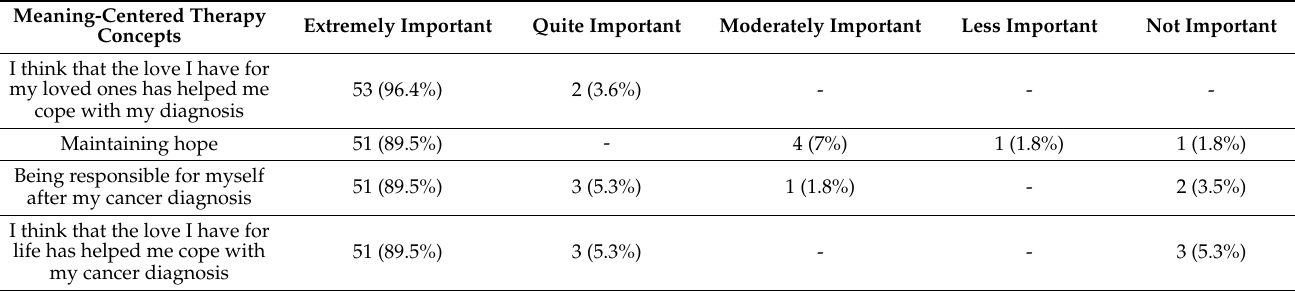
Table 6. Meaning-centered psychotherapy concepts: